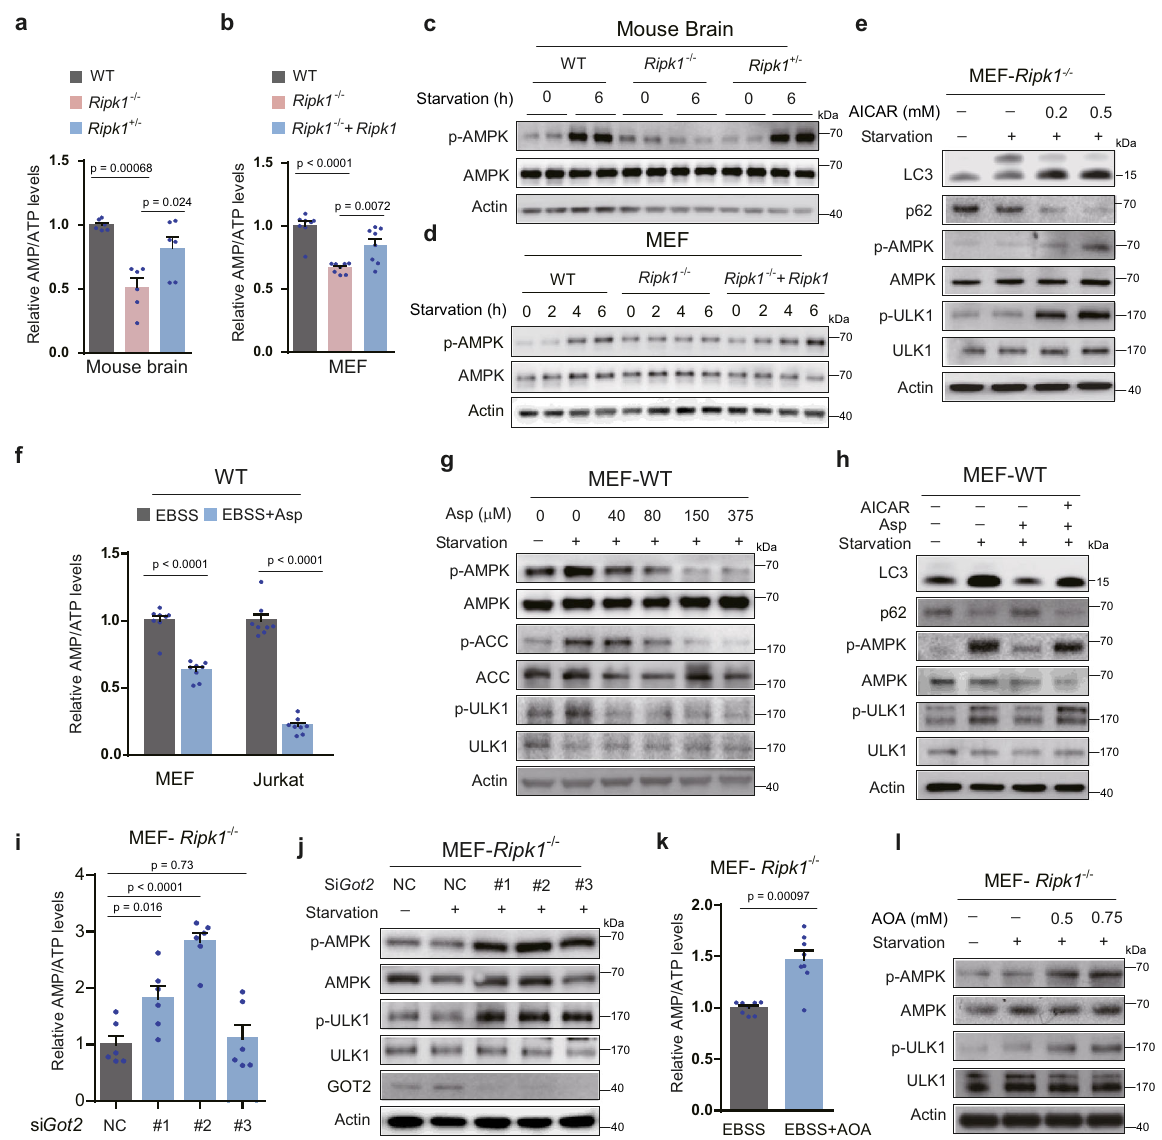
AICAR in culture medium or EBSS for 4 h. f Relative intracellular AMP/ATP ratios in WT MEFs and Jurkat cells were measured by the luminescent assay. Cells were cultured under EBSS or EBSS supplemented with aspartate (375 μ M) for 4 h before harvest ( n = 8 biologically independent samples per group). P values were determined by a two-tailed Student ’ s t -test. g Western blot analyses of p-AMPK, AMPK, p-ACC, ACC, p-ULK1, and ULK1 levels in WT MEFs treated with aspartate as indicated. h Western blot analyses of LC3, p62, p-AMPK, AMPK, p-ULK1, and ULK1 levels in WT MEFs treated with AICAR (0.5 mM, 4 h) and aspartate (0.15 mM; 4 h) in EBSS as indicated. i Relative intracellular AMP/ATP ratios in Ripk1 − / − MEFs were detected by the luminescent assay. Ripk1 − / − MEFs were transfected with nontarget control (NC) or Got2 siRNAs (#1 – 3), and cultured in EBSS for 4 h ( n = 6 biologically independent samples per group). P values were determined by a two-tailed Student ’ s t -test. j Western blot analyses of p-AMPK, AMPK, p-ULK1, and ULK1 levels in Ripk1 − / − MEFs responding to Got2 knockdown. Got2 knockdown ef fi ciency was detected using GOT2 antibodies. Cells were transfected with NC or G ot2 siRNAs (#1 – 3), and cultured in normal medium or EBSS for 4 h. k Relative intracellular AMP/ATP ratios in Ripk1 − / − MEFs responding to AOA treatment (0.75 mM, 4 h) under starvation conditions (EBSS, 4 h). AMP and ATP were detected by the luminescent assay. The ratios were normalized to the AOA-untreated group ( n = 8 biologically independent samples per group). P values were determined by a two-tailed Student ’ s t -test. l Western blot analyses of p-AMPK, AMPK, p-ULK1, and ULK1 levels in Ripk1 − / − MEFs responding to AOA treatment. Cells were cultured for 4 h in culture medium or EBSS with or without AOA as indicated. Bar graphs represent mean ±